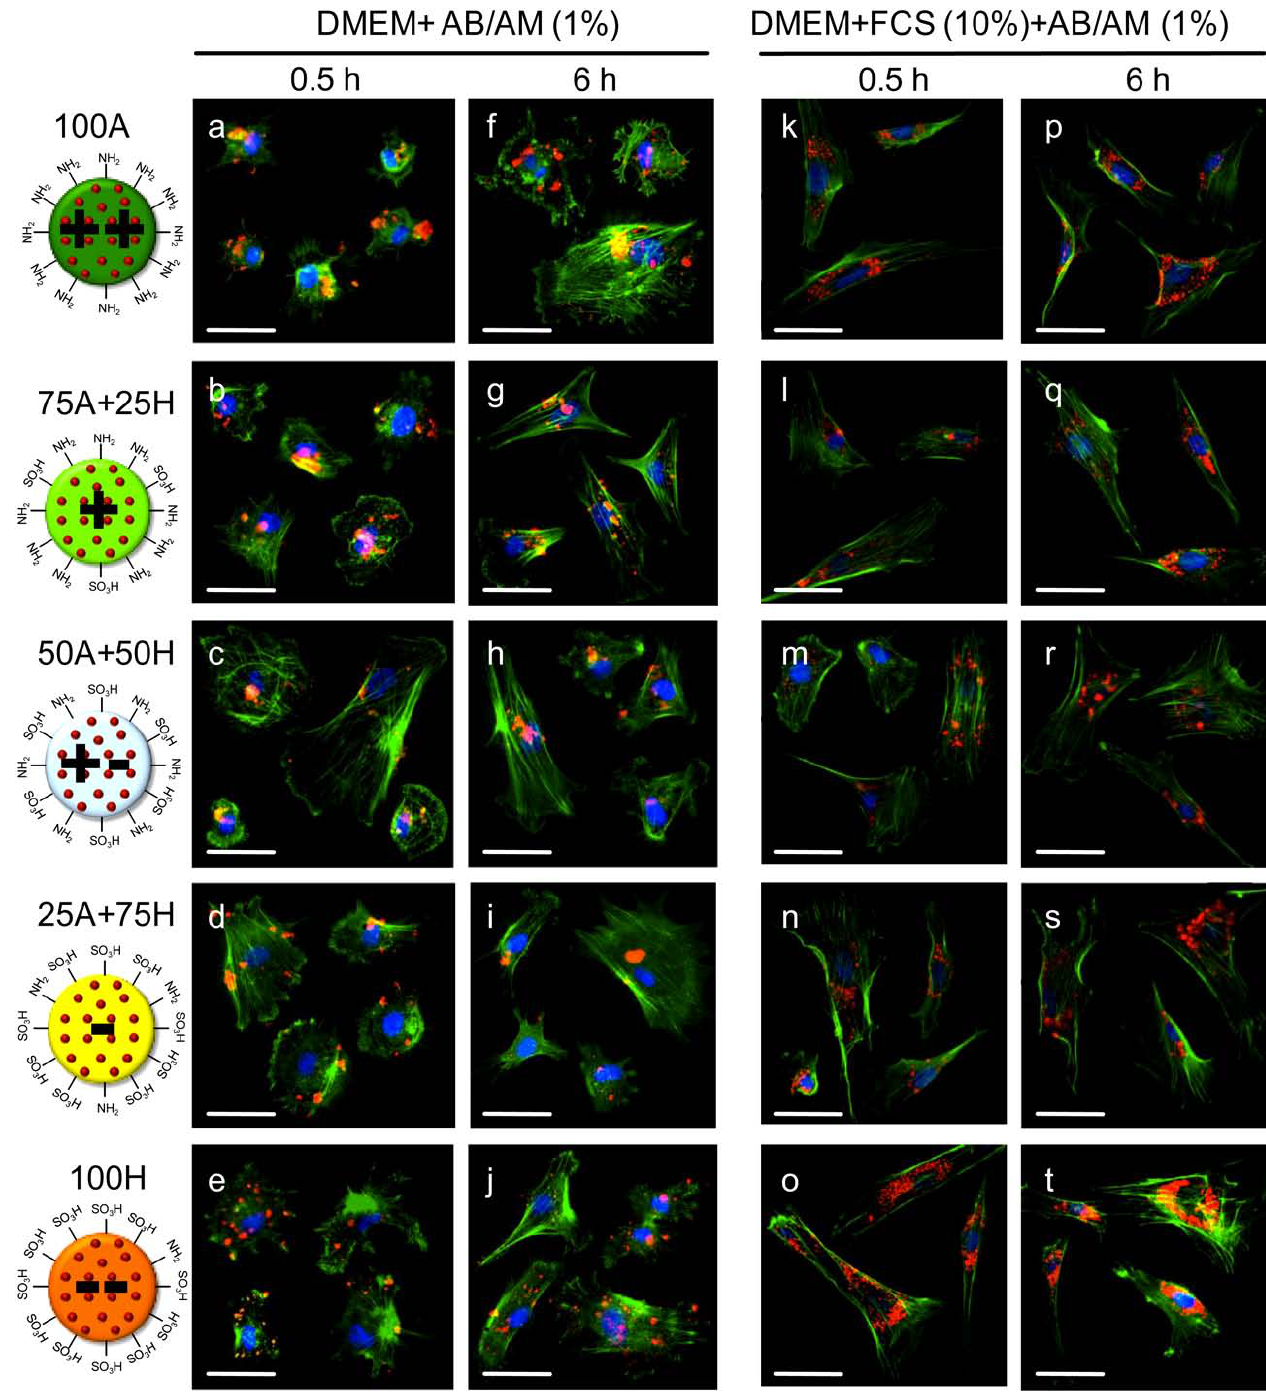
Fig. 7. Fluorescence microscopy micrographs of HOB osteoblasts incubated without (a (cid:2) j) or with (k (cid:2) t) FCS for 0.5 or 6 h at 37 (cid:3) C with 100 (cid:1) g mL (cid:2) 1 FSNP, revealing cellular uptake and intracellular localization of the particles. Green, blue, and red °uorescence indicates the actin cytoskeleton, the nuclei, and FSNP, respectively. Scale bars: 50 (cid:1) m. Reprinted with permission from Ref. 115. This is an uno±cial adaptation of an article that appeared in an ACS publication. ACS has not endorsed the content of this adaptation or the context of its use. Copyright ° c 2015 American Chemical